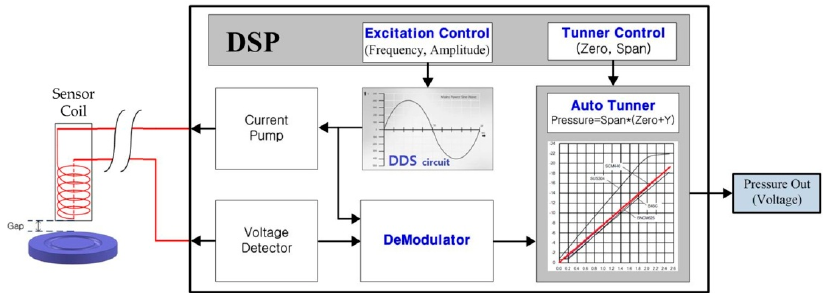
Figure 3. Functional block diagram for signal processing of eddy current acquisition.